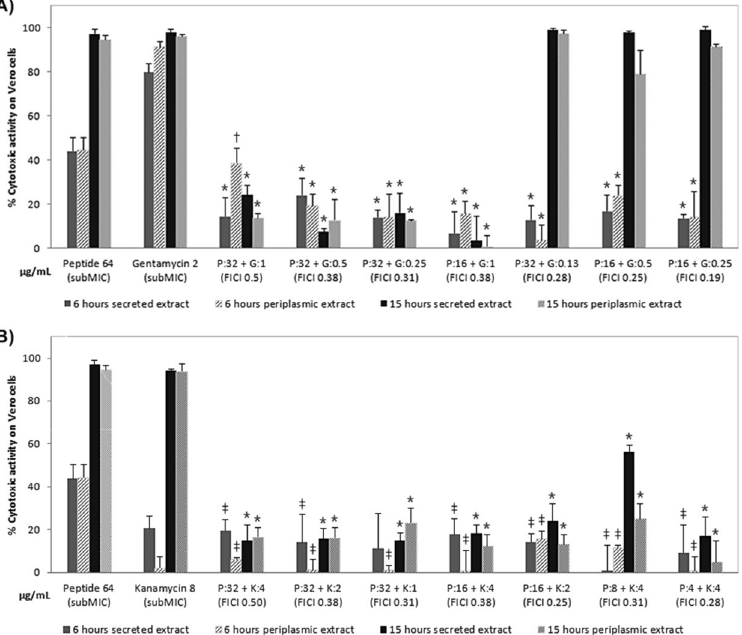
Figure 3. Vero cell cytotoxicity levels with secreted and periplasmic lysates from STEC 86–24 following treatment with peptide or antibiotic or peptide-antibiotic combinations after 6 hr and 15 hr. ( A ) with subMIC peptide-gentamicin combinations with specified FICI values ( B ) with subMIC peptide-kanamycin combinations with specified FICI values. All assays were carried out in triplicate and on at least two occasions. Data bars represent means ± standard deviation. * Significantly different from both individual treatments (peptide or antibiotic); † Significant different from antibiotic treatment. ‡ Significantly different from peptide treatment; P < 0.05; One-way ANOVA with post hoc Tukey